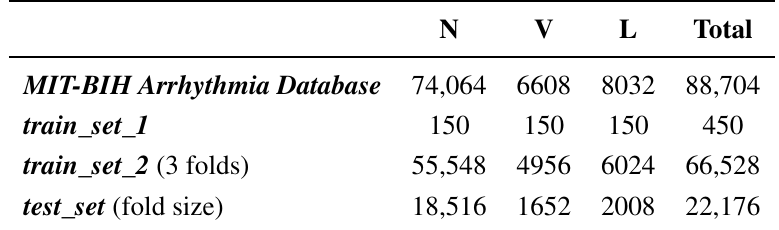
Table 1. Composition of the sets of heartbeats employed in the different